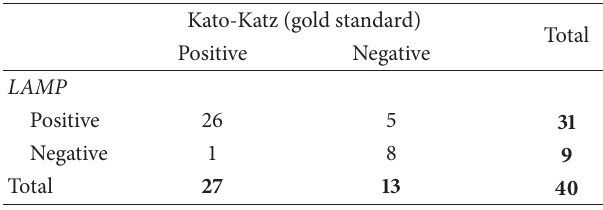
Table 3: Contingency table assessing accuracy of LAMP in relation to Kato-Katz technique.